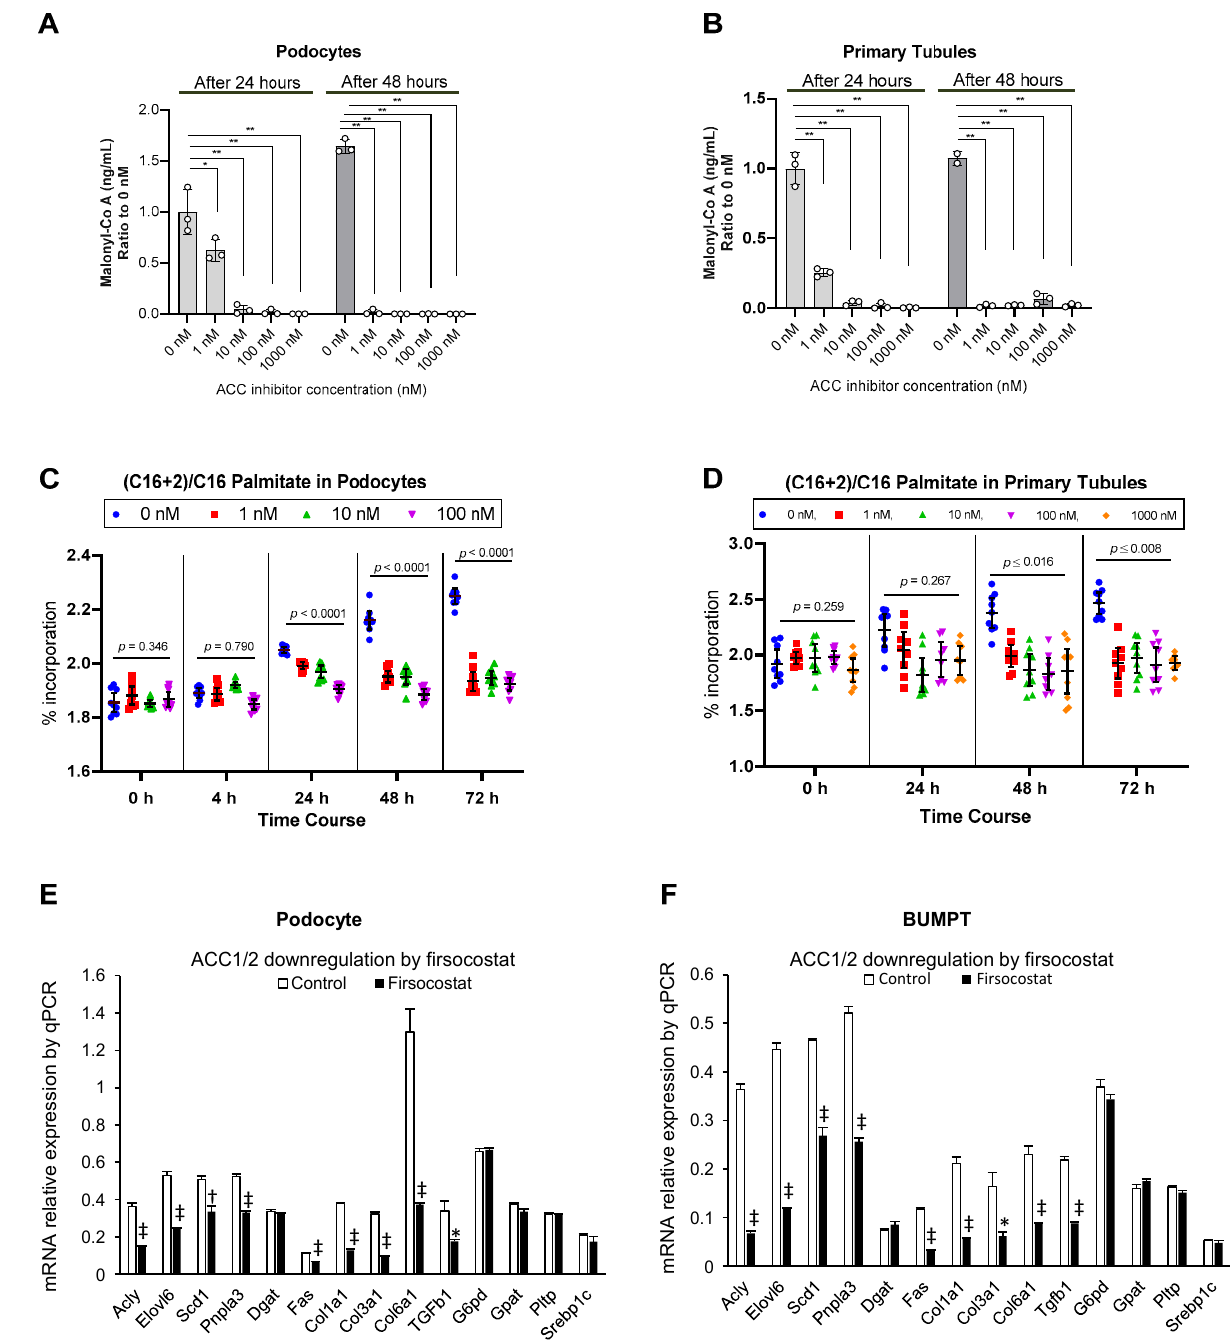
Figure 6. Down regulation of glycemic mediated DNL and change in expression of coregulatory genes by pharmacological ACC inhibitor in podocytes and primary tubular epithelial cells in vitro: Firsocostat exposure in podocytes ( A ) and primary tubular epithelial cells ( B ) cultured in high glucose concentration (25 mM) as compared to respective control cells showed a time and dose-dependent suppression of malonyl-Co A. Exposure to firsocostat halted increased percentage of labeled palmitate in high glucose concentration (25 mM) media over time compared to control cells in podocytes ( C ) and BUMPT cells ( D ) * p < 0.01, ** p < 0.001. Comparing the mRNA relative expression of gene markers in podocytes ( E ) and BUMPT cells ( F ) treated with firsocostat (1 µ M) compared with control group. * p < 0.05, † p < 0.01, ‡ p < 0.001. Values are mean and 95% confidence interval in panels C and D and mean with standard error in other panels. Number of experiments is 3 in all panels with each experiment running in triplicates in panels C and D.